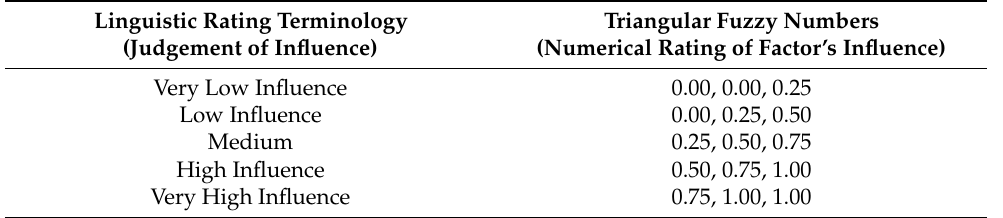
Table 2. Fuzzy linguistic ratings.